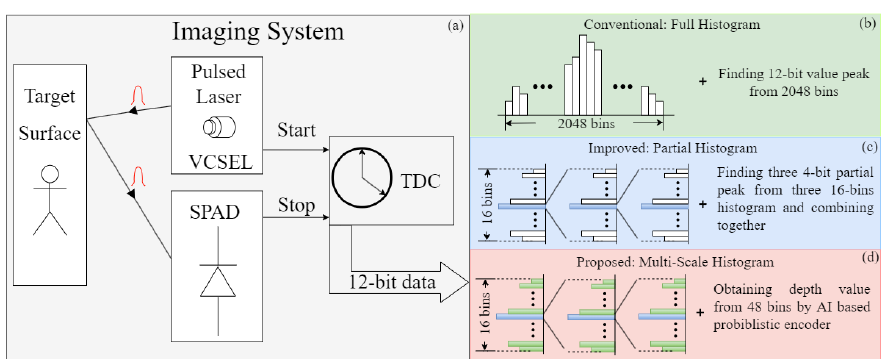
Figure 1. Comparison with previous works: ( a ) Imaging system including Vertical-Cavity Surface- Emitting Laser (VCSEL)-based TX, SPAD-based RX, and 12-bit TDC to calculate the output. ( b ) Con- ventional method, which costs 2048 bins and peak finding calculation. ( c ) Improved way to limit the bin number to 48 bins and use peak finding calculation for 3 histograms. ( d ) Method in this work, which takes 48 bins as the inputs and with which the depth value is obtained using the proposed AI neural network.